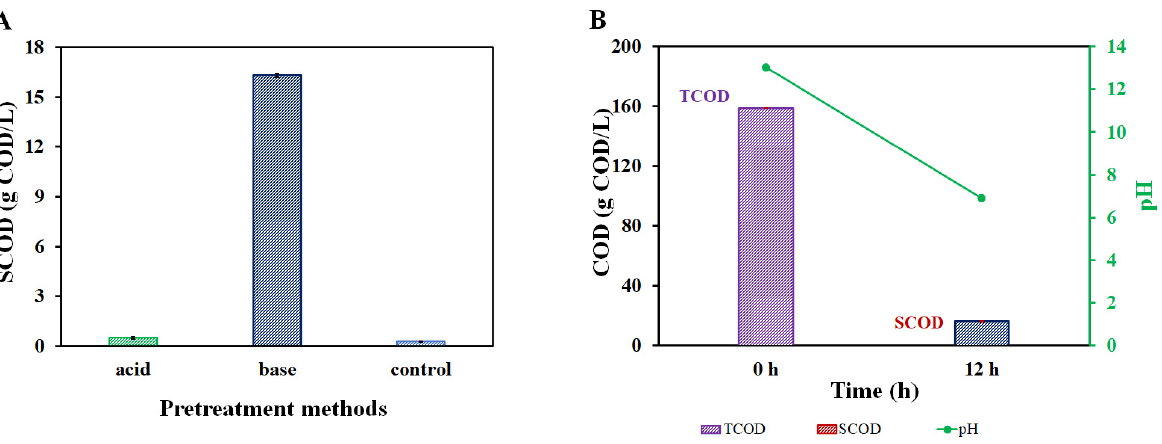
Figure 2. ( A ). Comparison of soluble COD (SCOD) after three pretreatments for PHBV. ( B ). COD (TCOD is the total COD of PHBV, and SCOD is measured soluble COD); and pH change between the start and end of alkaline pretreatment.